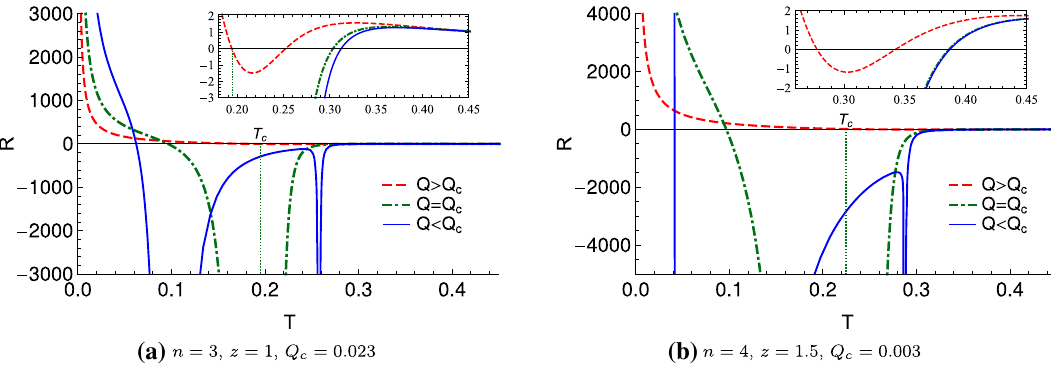
Fig. 5 The behavior of H M versus T for the linear Maxwell case with l = b = 1 S , Q